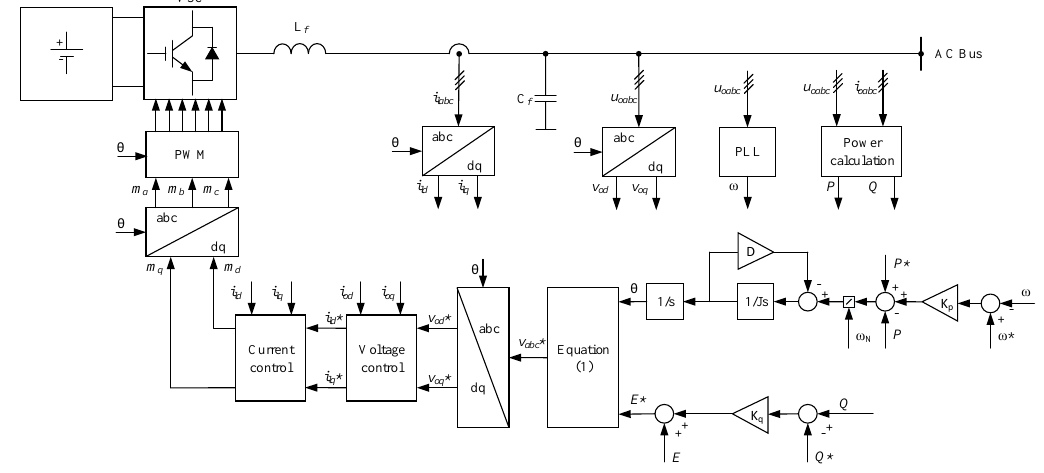
Figure 2. Control scheme of the virtual synchronous generator control–based grid-forming converter.